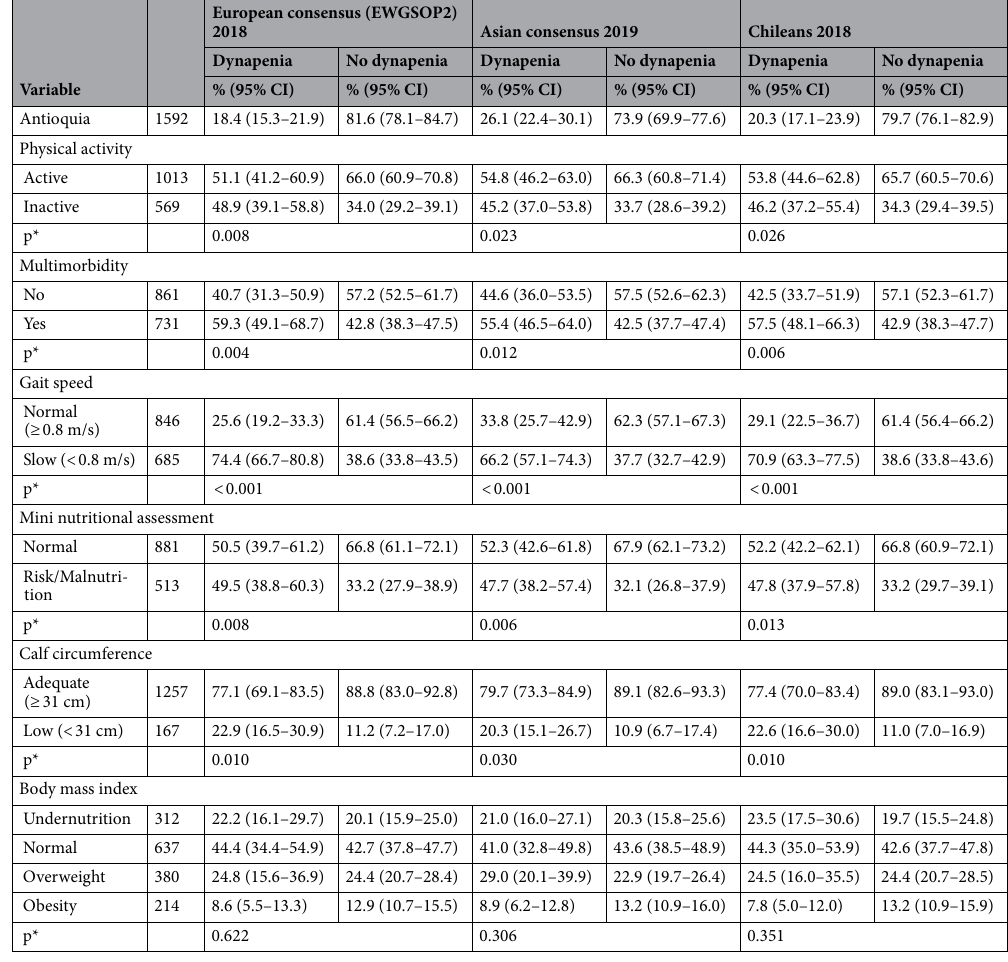
Table 2. Health, functional and anthropometrics characteristics according to dynapenia by European, Asian consensus and Chilean cutoffs. European consensus EWGSOP2 2018: European Working Group on Sarcopenia in Older People update in 2018 5 . Asian consensus 2019 11 . Chileans 2018: Reference values of handgrip dynamometry in older Chileans 13 . *Maximum likelihood